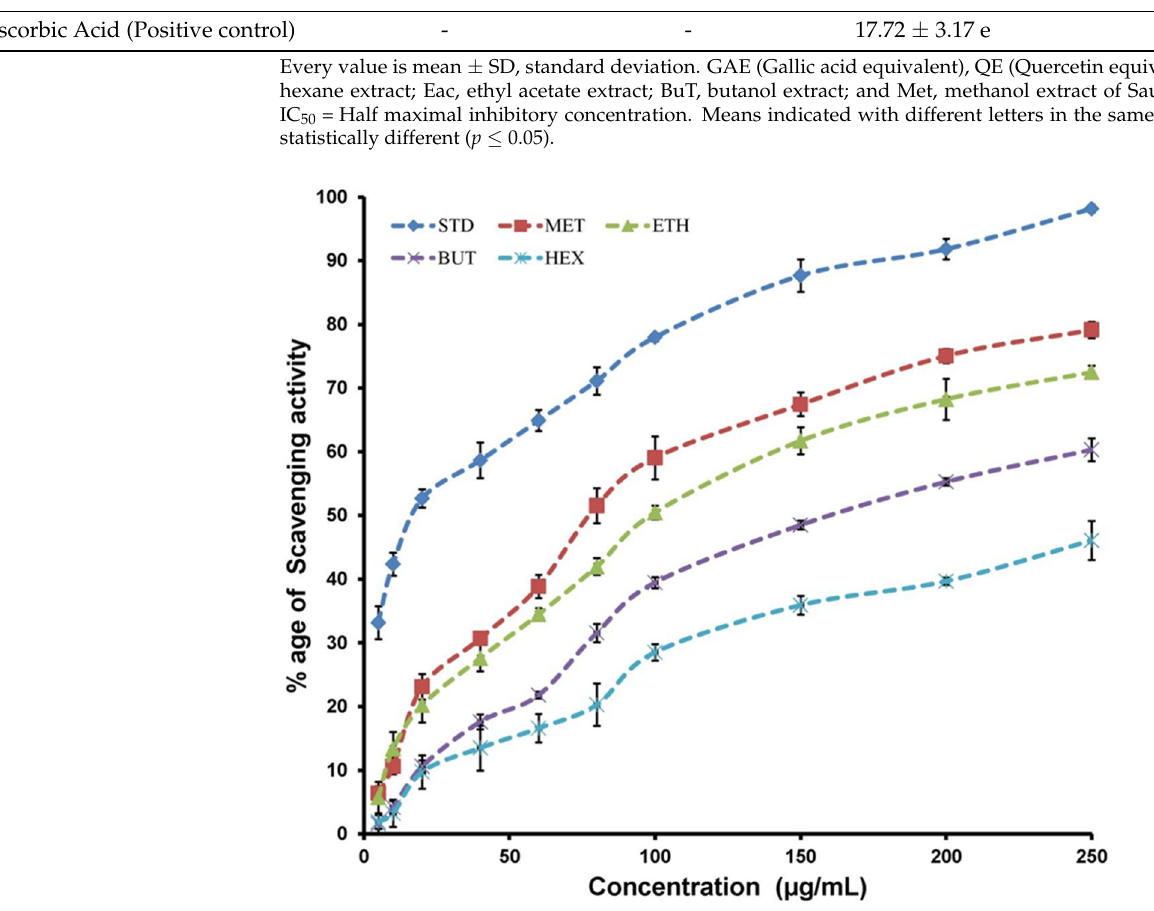
Figure 2. Consequences of quantity ( µ g/mL) on antioxidant behavior of different Saudi-propolis based extracts (HEX = hexane, ETH = ethyl acetate, BUT = butanol, MET = methanol) and CTL =